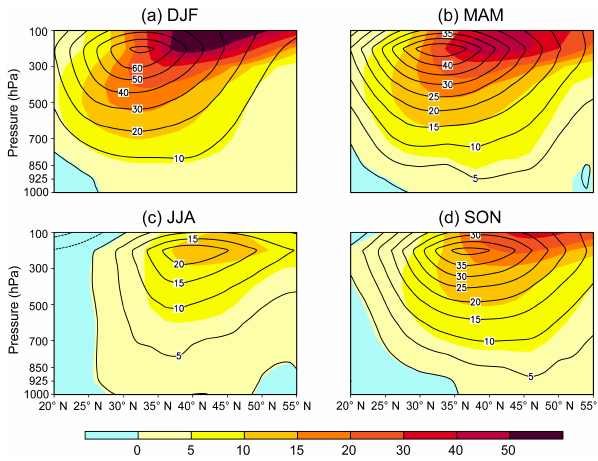
Figure 6. The pressure–latitude cross sections along 135 ◦ E of the simulated seasonal O 3 outflow fluxes and zonal winds in four seasons averaged from 1997–2006 in the MetEmisB simu- lation. The O 3 mass fluxes are shown by the colored shading (kgseason − 1 m − 2 ) , and the winds are represented by the contours (ms − 1 ) . The positive values represent eastward fluxes, and the neg- ative values represent westward fluxes.